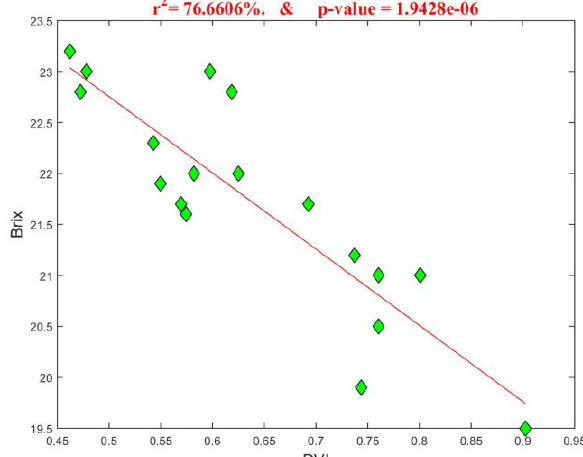
Figure 2. BRIX – DVI comparison provided the best correlation results for the 2014